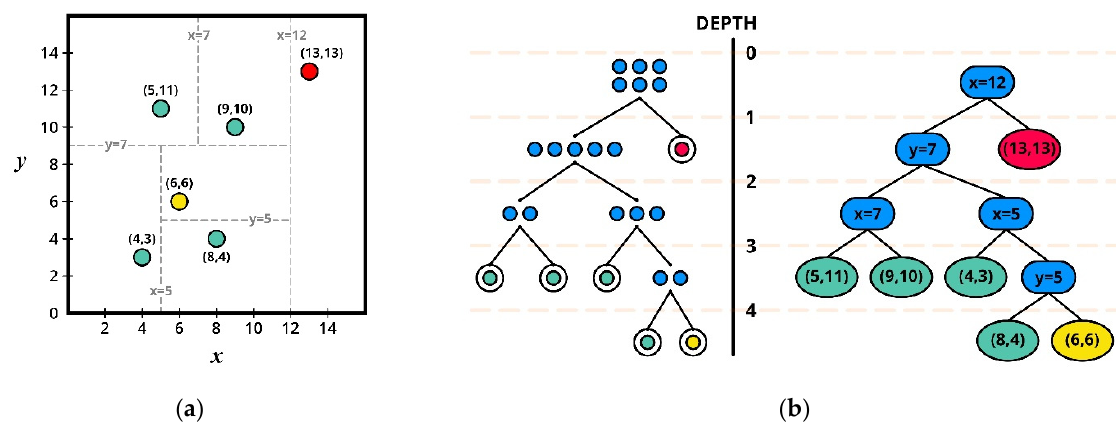
Figure 3. Conceptual illustration of isolation forest: ( a ) isolation operations of data points using randomly constructed binary search tree; ( b ) binary tree with the isolated point.